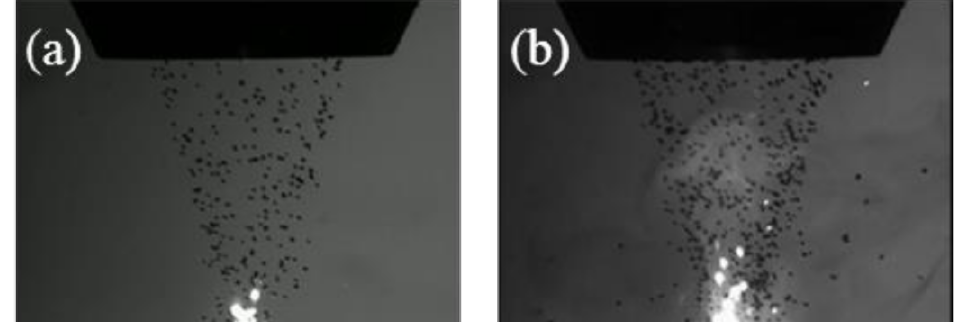
Figure 8. State of powders and plasma under laser irradiation with laser power 900 W captured by high-speed camera: ( a ) nearly no plasma was induced, ( b ) some powders exploded randomly and induced